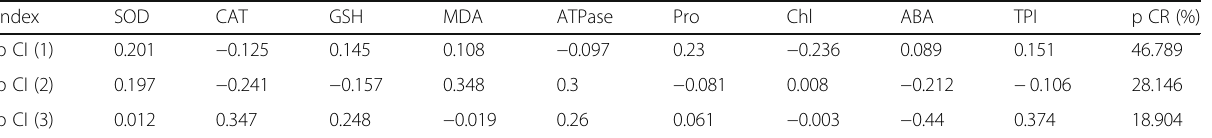
Table 2 The coefficients of comprehensive index p CI (x) and contribution rate